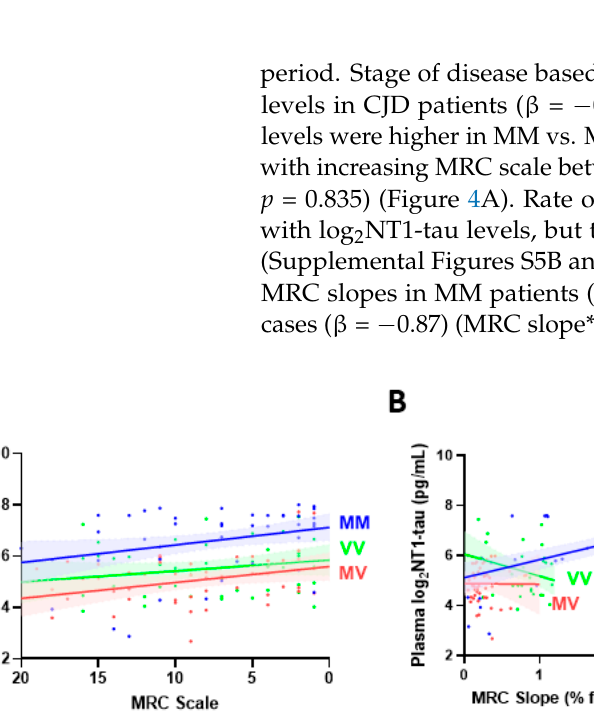
Figure 4. Plasma NT1-tau levels positively correlate with disease progression in CJD subjects. Samples from Study 3 and baseline samples from Study 4 comprised plasma specimens from 145 CJD patients. Association of plasma NT1-tau levels with ( A ) severity of functional impairment measured with the MRC Scale, and ( B ) the rate of clinical progression determined with the MRC Slope was modelled using linear regression stratified by (PRNP) polymorphism at codon 129. ( A ) Severity of functional impairment (lower MRC Scale) correlated with higher plasma log 2 NT1-tau levels in CJD patients (Supplemental Figure S5A). Plasma log 2 NT1-tau levels were higher in MM (blue) vs. MV (red) and VV cases (green) ( p < 0.001), but the slopes were not significantly different between codon genotypes (MRC scale*Codon129 interaction: p = 0.835). ( B ) A faster rate of clinical progression (greater MRC Slope) was associated with increased levels of log 2 NT1-tau in MM (blue), but not in MV (red) and VV cases (green) (MRC slope*Codon129 interaction: p = 0.012). ( C ) Study 4 samples were from 17 MV CJD cases and included a total of 46 longitudinal plasmas. Fold changes in repeated NT1-tau measures were calculated relative to the measurement at initial visit, and are expressed as relative plasma NT1-tau levels. Association of plasma NT1-tau levels with MRC Scale was modelled using a linear mixed effects regression. Shaded areas represent 95% confidence intervals. Spaghetti plots show repeated measures for individual subjects. Relative plasma NT1-tau levels increase moderately in MV cases ( p = 0.008). Repeated measures were only available from a limited number of MM ( n = 2) and VV ( n = 5) cases, and are shown in Supplemental Figure S5C.